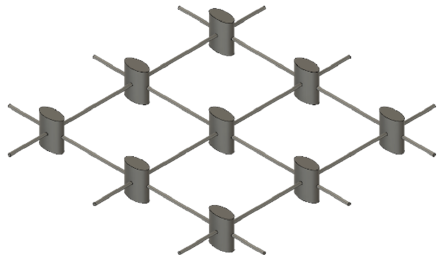
Figure 1. A view of the morphology of the pillar-like feed spacer.